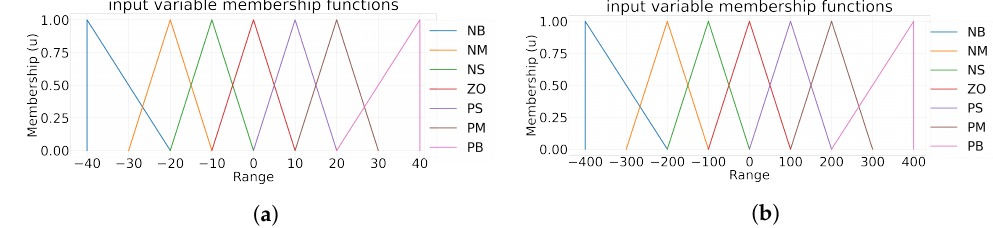
Figure 15. ( a ) Input Membership Function of e [ t ] for the APS. ( b ) Input Membership Function of (cid:82)